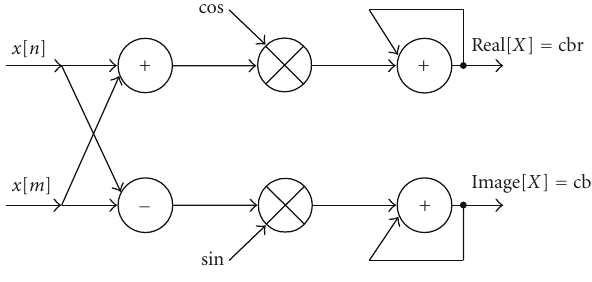
Figure 4: Data flow graph of the CBT